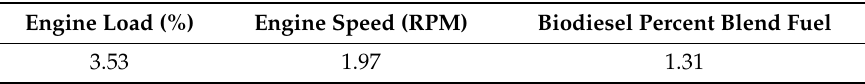
Table 6. The sensitivity analysis of